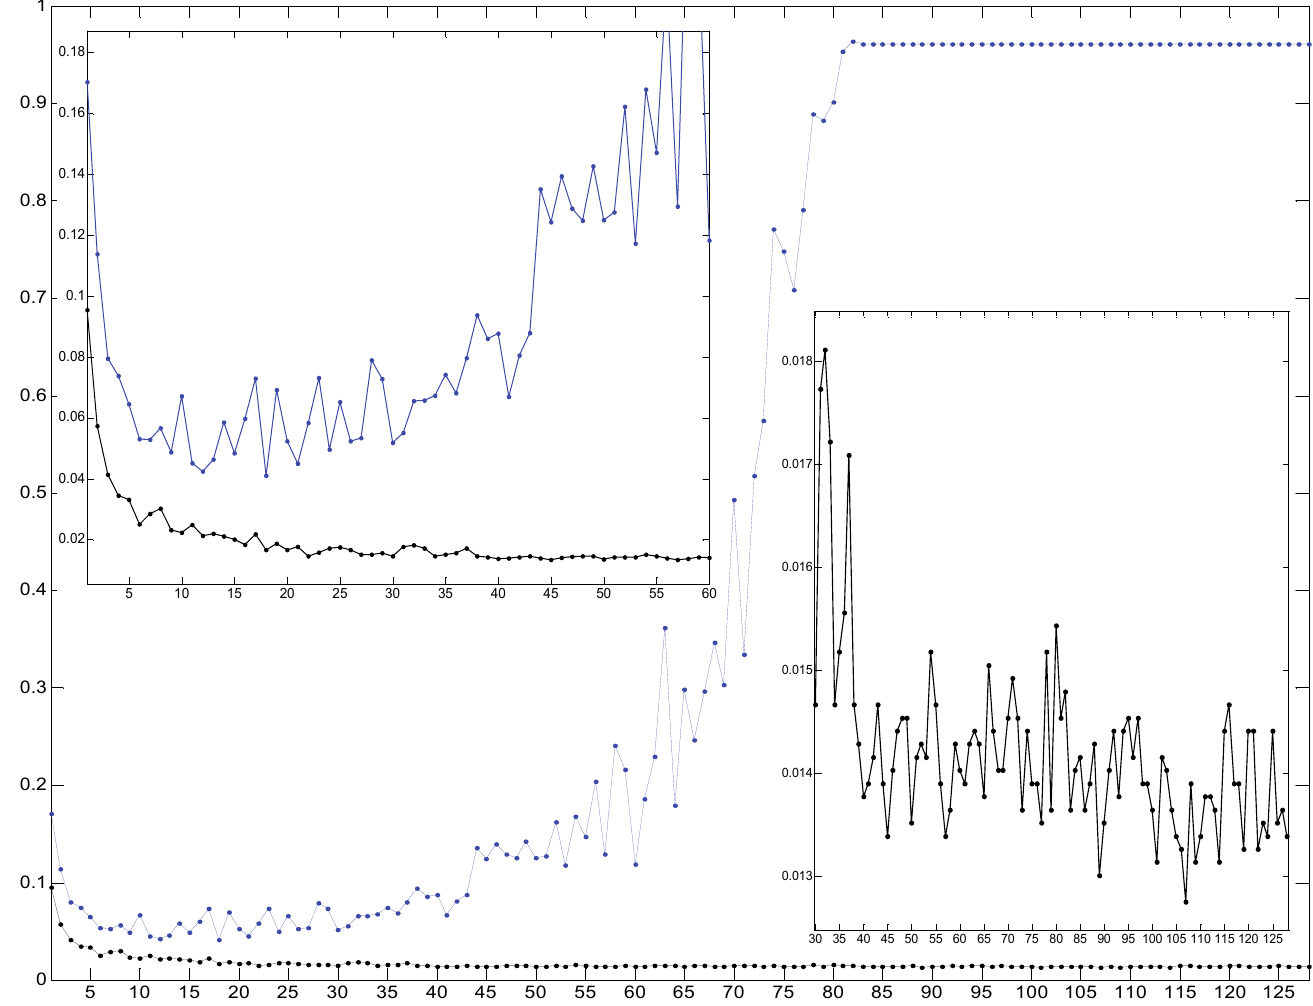
Fig. 6. The performance   28 V by (19) at 1,128 p  as the lower polyline against the upper polyline   17